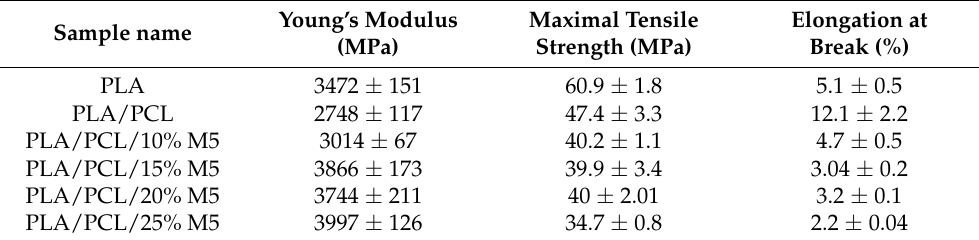
Table 5. The tensile properties of the 3D-printed PLA, PLA/PCL, and their